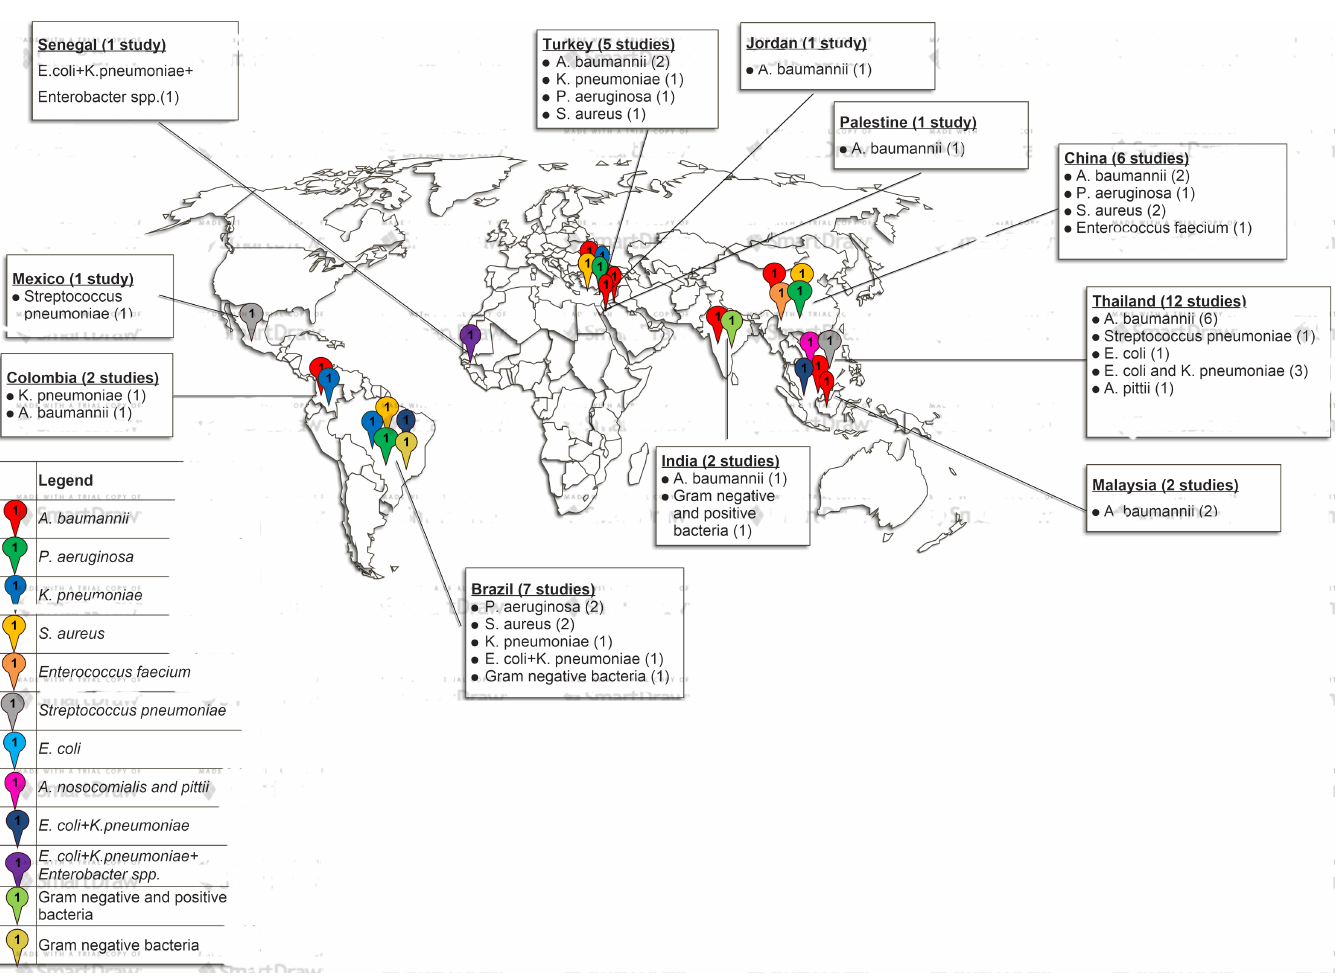
Fig 2. Graphical representation of AMR in developing countries included in the